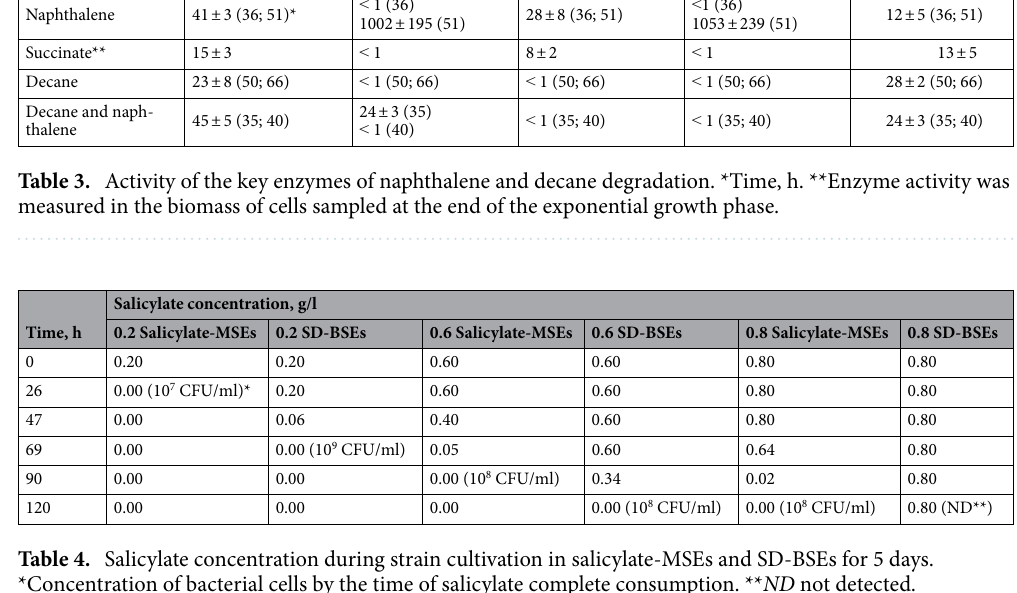
Table 4. Salicylate concentration during strain cultivation in salicylate-MSEs and SD-BSEs for 5 days. *Concentration of bacterial cells by the time of salicylate complete consumption. ** ND not detected.